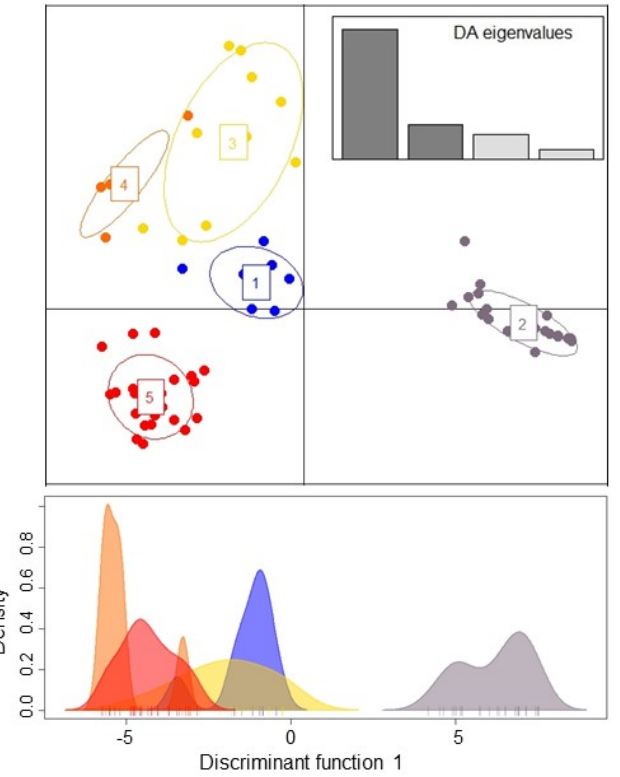
Figure 2. DAPC of Danish and Iranian individuals of Candida parapsilosis based on STR data. Scatter plot represents the distribution of individuals (dots) among the five clusters (top). A single discriminant function plotted along the x -axis (bottom).